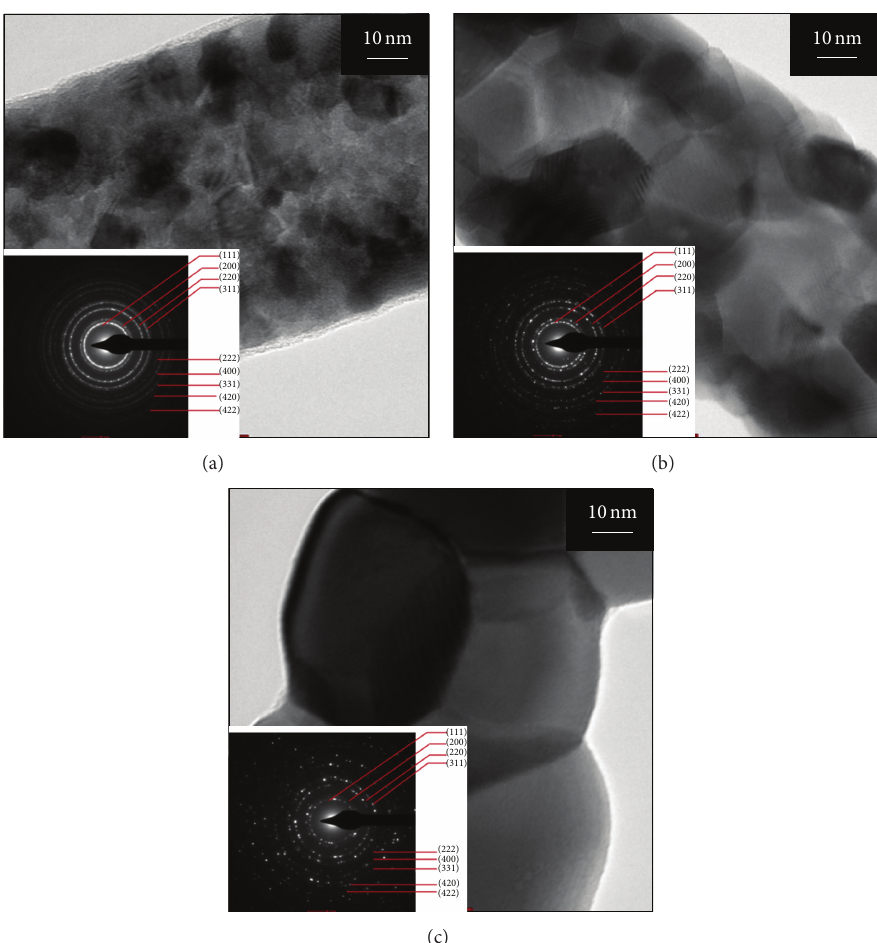
Figure 5: TEM bright field images and selected area electron diffraction (SAED) patterns of GDC20 nanofibers calcined in air at different temperature for (a) 500 ∘ C, (b) 700 ∘ C, and (c) 900 ∘ C for 8h.